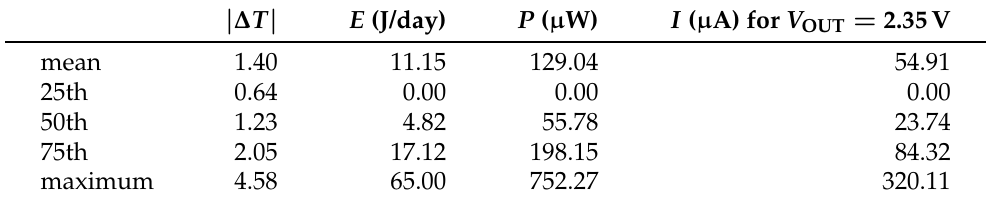
Figure 15. Histogram of daily harvested energy over the course of one year. On most days of the year, the quantity of energy harvested was between 0 and 5 J. Table 7. Statistical parameters of daily harvested energy, daily average electrical power and calculated output current for the specified voltage.